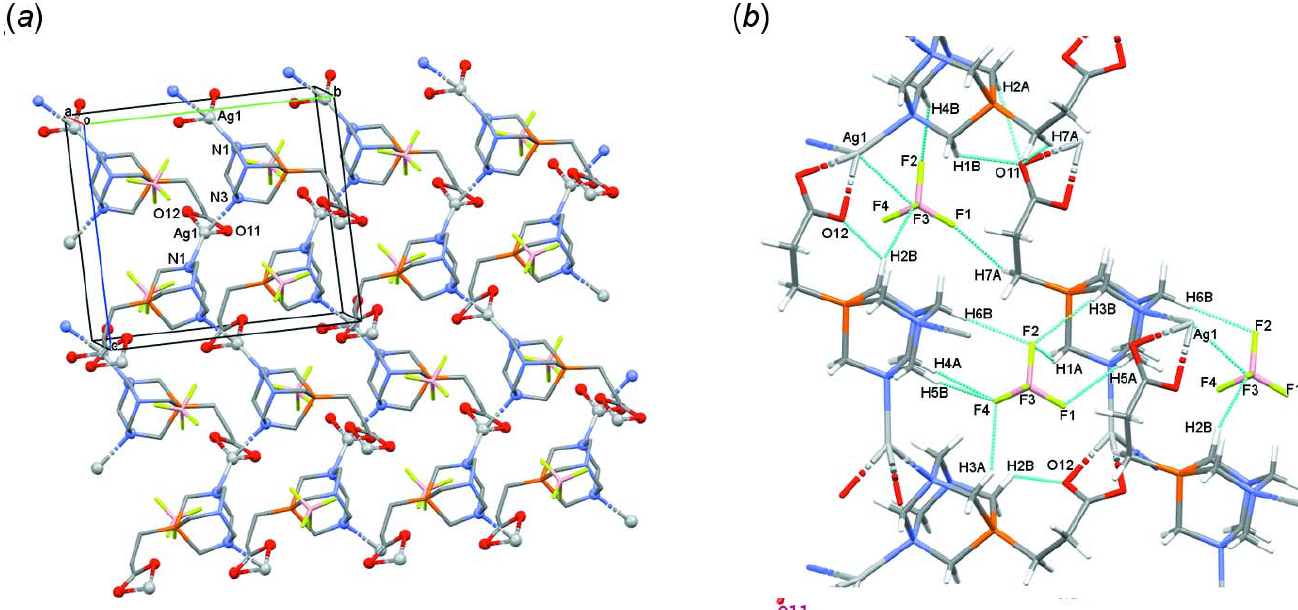
Figure 3 ( a ) Packing arrangement of the three-dimensional structure of the CP in the crystal viewed along the crystallographic a axis. The coordination sphere is labelled and highlighted by a ball-and-stick model. Hydrogen atoms are omitted for clarity. ( b ) Selected hydrogen-bond geometry in the CP showing the weak C—H (cid:5)(cid:5)(cid:5) F and C—H (cid:5)(cid:5)(cid:5) O secondary interactions, as well as the Ag1 (cid:5)(cid:5)(cid:5) F3 interaction. For symmetry codes, see Table 1.